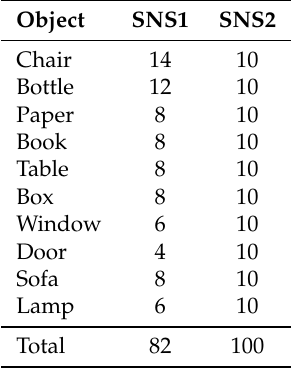
Table 1. 10-Class Datasets Statistics.